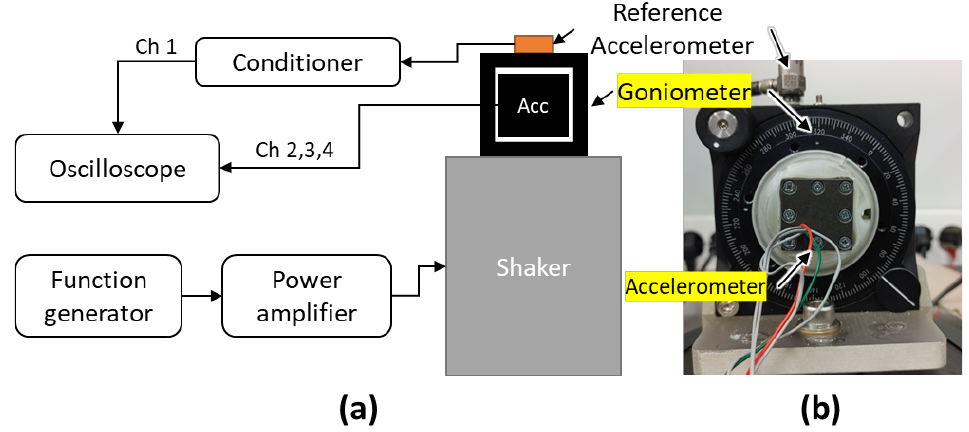
Figure 8. ( a ) Schematic illustration and ( b ) photograph of the directivity measurement setup.